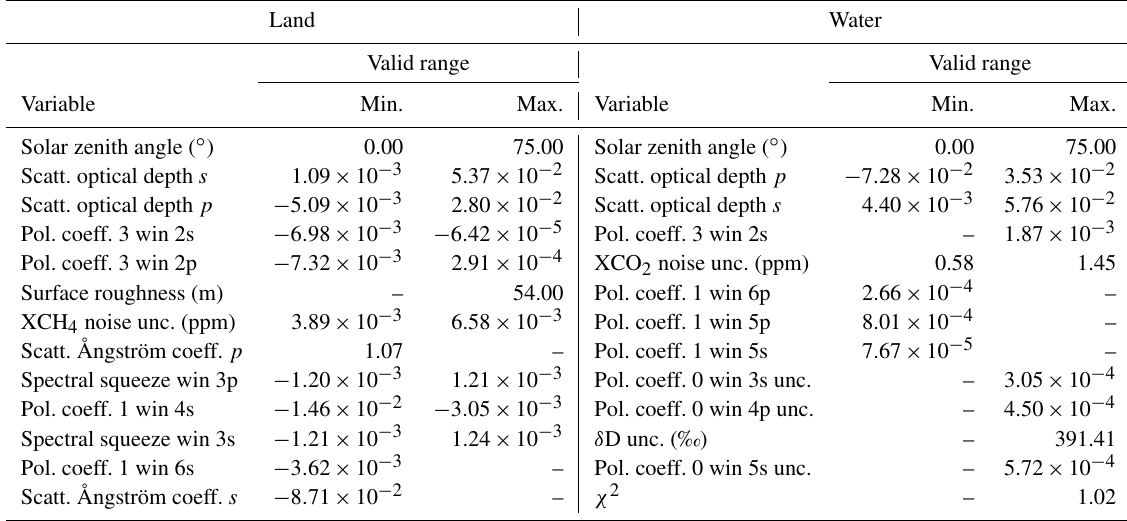
Table A1. XCO 2 filter variables and limits for GOSAT. “–” means that no limit is applied. Except for the solar zenith angle limits, the variables are ordered by their relevance, i.e. by the number of data filtered out.